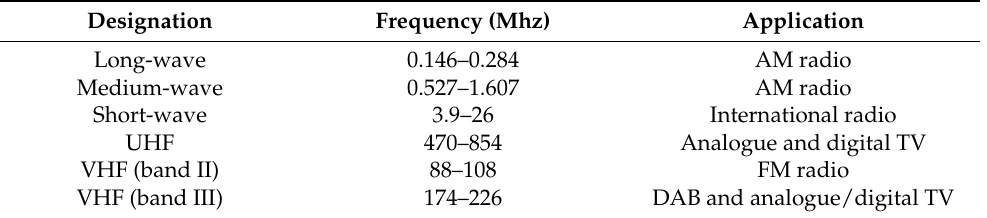
Table 3. Frequency bands for television and radio signals